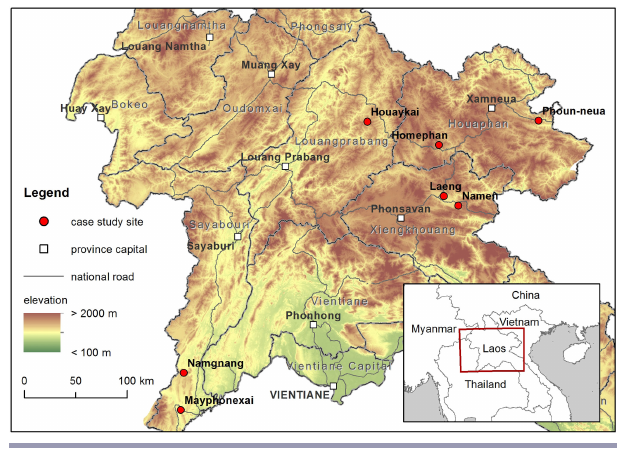
Fig. 2 . Location of selected case study sites for field survey (incl. local games) in northern